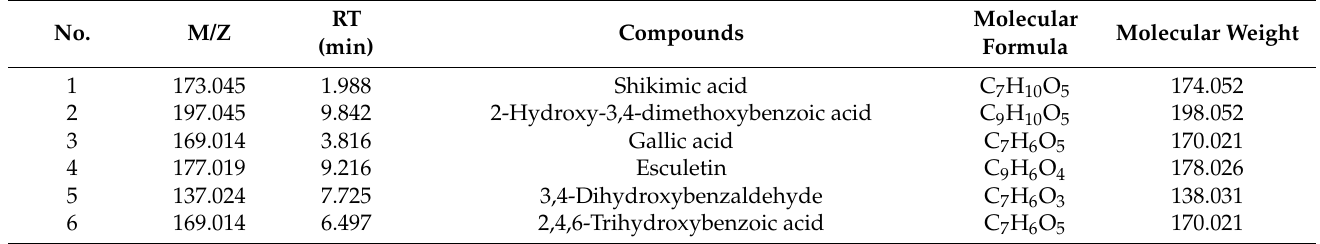
Table 4. Compounds identified in the ethanolic extract of Prabchompoothaweep remedy by LC-